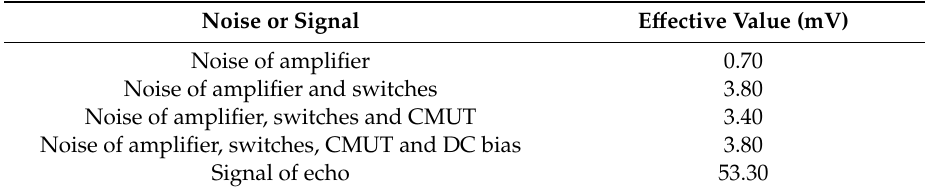
Table 1. E ff ective values of noise and signal.